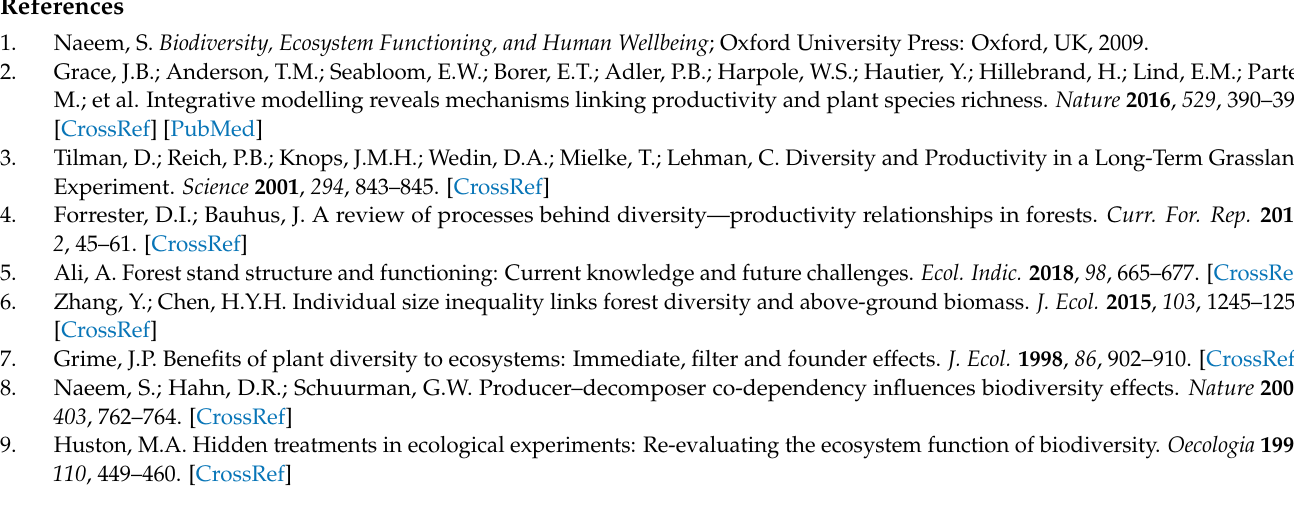
Table S2: Pearson correlation analysis of species diversity, structural diversity, aboveground biomass, and environmental factors. Table S3: Summary of variables used in analyses in Tiantong plot. Table S4: Summary of the generalized least-squares (GLS) models of productivity on predictors at Tiantong plot. Table S5: Model comparison results of multiple linear mixed models predicting the log response ratio of productivity ( ∆ AGB). Listed are the top 5 models. Standardized regression coefficients (Beta) for each predictor are given. Selected optimal models are highlighted in grey color. Figure S1: Soil sampling map in the 20-ha Tiantong forest dynamics plot. Figure S2: Non-metric multidimensional scaling ordination of Tiantong plot. NMDS output showing site scores (red dots) and species scores (blue text) of the ten most abundant species. Figure S3: Principal component analysis (PCA) of elevation, aspect, and slope. Figure S4: Principal component analysis (PCA) of total nitrogen (TN), total phosphorus (TP), pH value (pH), and soil depth